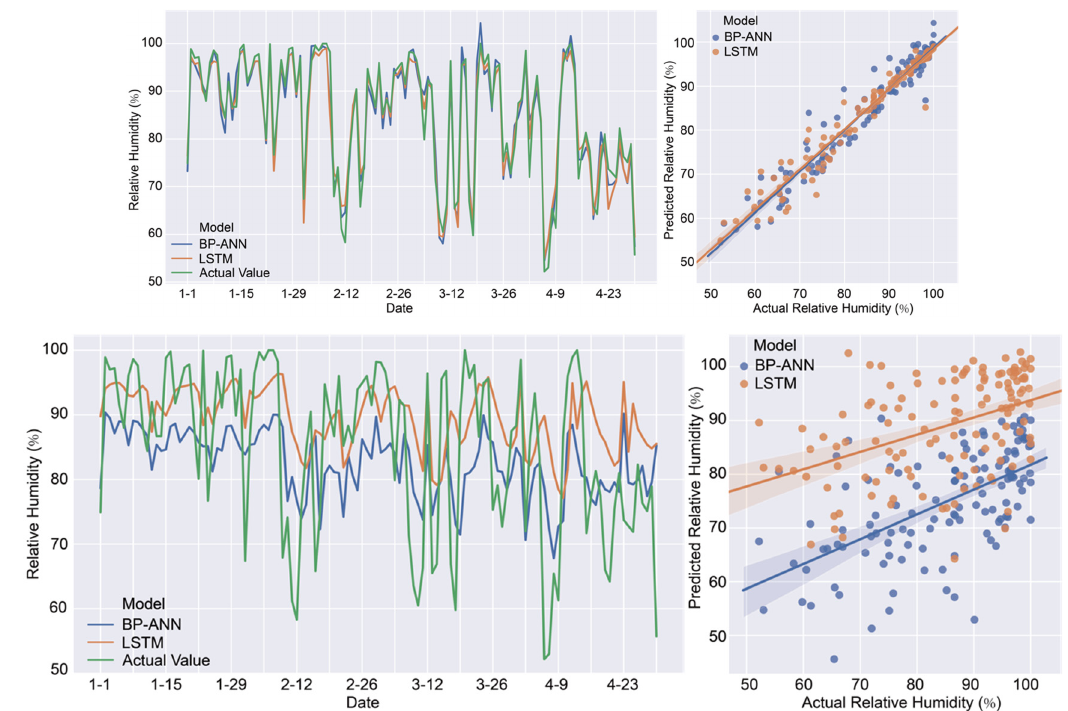
Figure 9. The prediction results of daily maximum RH using BP-ANN and LSTM techniques in Model 1 ( up ) and 2 ( below ).